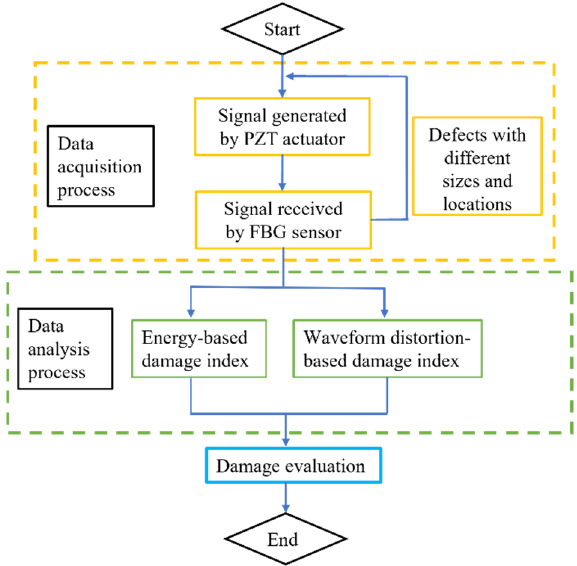
Figure 2. Flowchart of the proposed damage evaluation method on railway tracks.